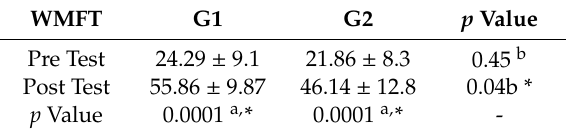
Table 2. The mean values of Wolf Motor Function Test (WMFT) of the a ff ected UL in both groups.